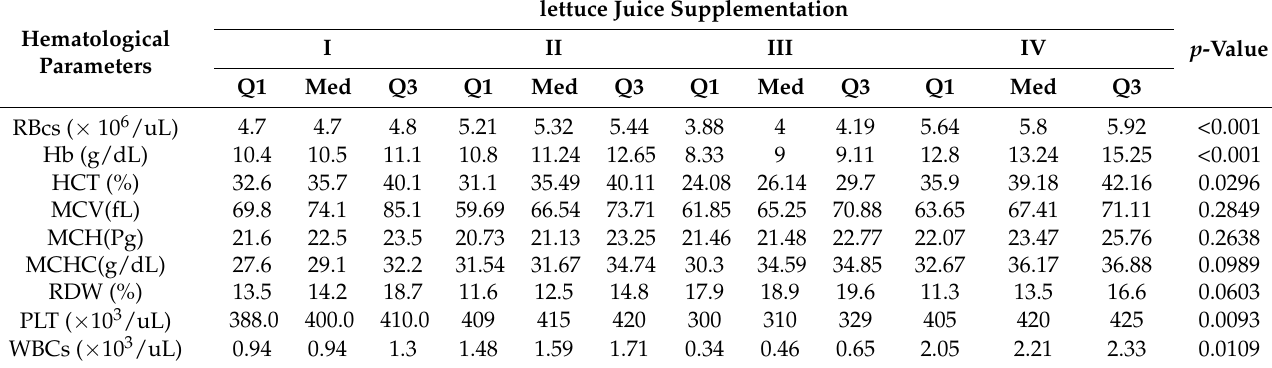
All rabbit groups received diets explained in Table 2, and lettuce treatments were as follows: I: negative control (healthy animals); II: non-fertilized lettuce; III: nitrate-fertilized lettuce; IV: WPH-fertilized lettuce. RBC: red blood cell; Hb: hemoglobin; HCT: hematocrit; MCV: mean corpuscular volume; MCH: mean corpuscular hemoglobin; MCHC: mean corpuscular hemoglobin concentration; RDW: red cell distribution width; PLT: platelet counts, WBC: white blood